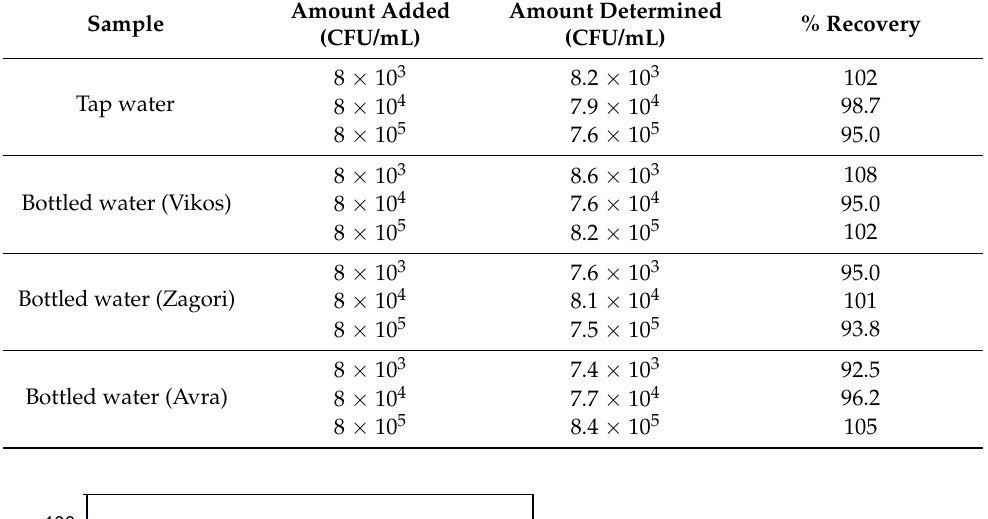
Table 1. Recovery of known amounts of S. typhimurium bacteria spiked in four different water samples, including tap water and three bottled Greek natural mineral water products (Vikos, Zagori, and Avra).